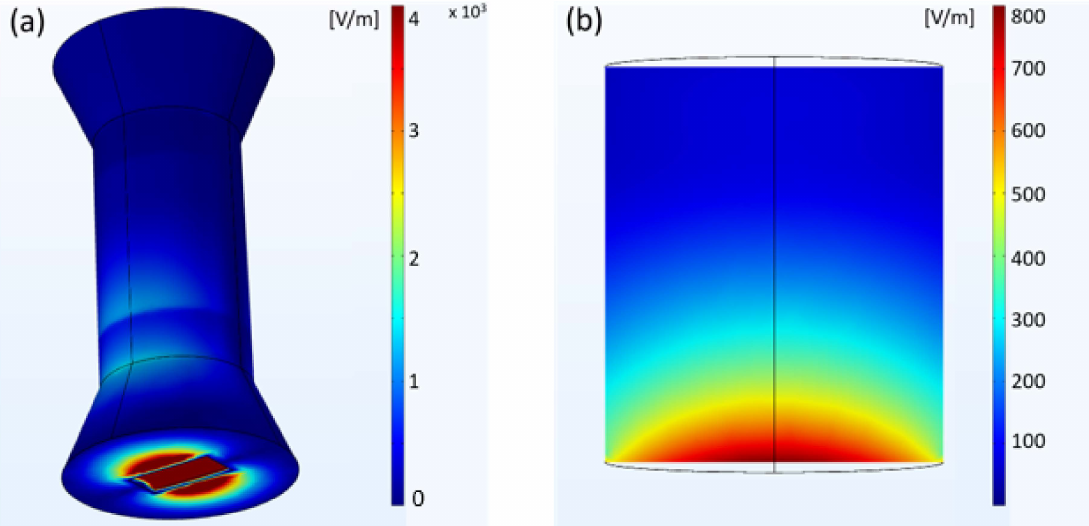
Figure 14. ( a ) Volume distribution of the electric field in the adsorber, ( b ) Slice distribution of the electric field in the zeolite’s bed.